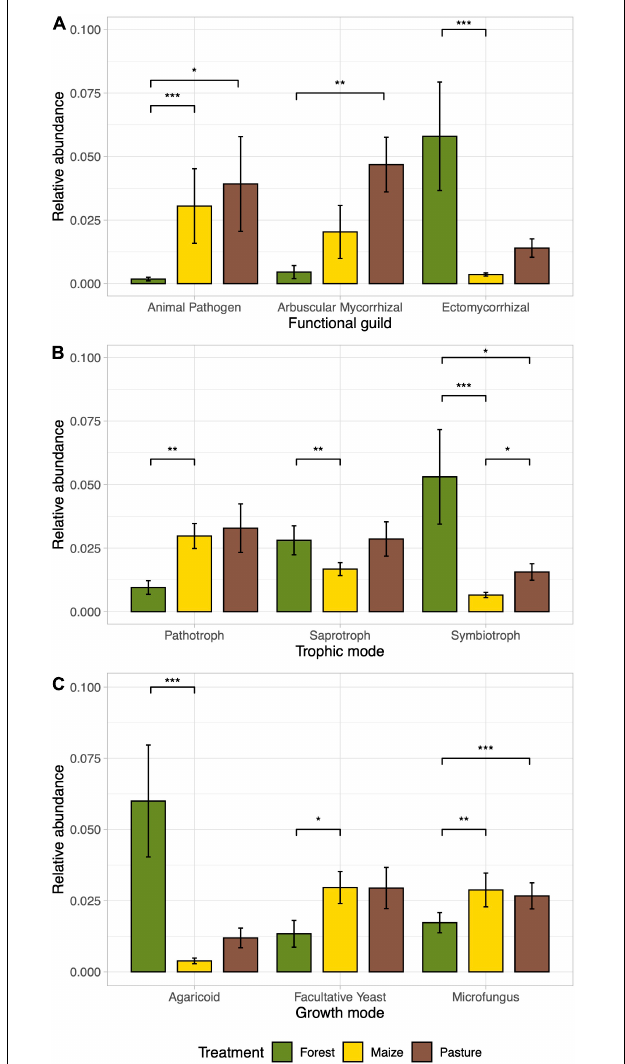
FIGURE 5 | Bar plots of the relative abundance of ecological guilds of the fungal communities differentially abundant between a coniferous forest soil (Forest), a deforested for grazing (Pasture), and a maize ( Zea mays L.) cultivated deforested soil (Maize) at the “ Área de Protección de Flora y Fauna Nevado de Toluca ” (Mexico). The bar height indicates the mean for each land use system and the error lines indicate the standard error of the mean. Functional guilds (A) , trophic mode (B) , and growth mode (C) as determined by FunGuild software. ANOVA-Like Differential Expression tool